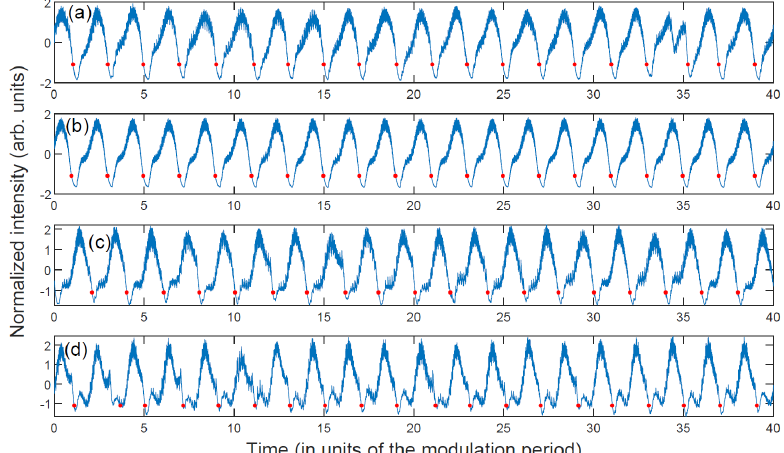
Figure 4. Intensity time series for a mod = 0.01 ( a ), 0.0125 ( b ), 0.02 ( c ), 0.03 ( d ). f mod = 24 MHz; other parameters are as indicated in the